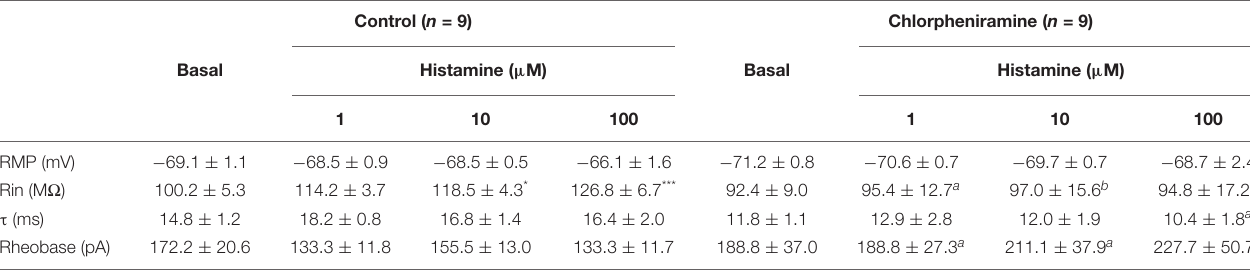
Passive membrane properties were obtained from experiments illustrated in Figure 4 . The membrane time constant ( τ ) was obtained at − 30 pA. Differences within the same group were evaluated with repeated-measures two-way ANOVA and post hoc Dunnett’s multiple comparison test. *P < 0.05, ***P < 0.001 versus basal. Differences between groups were analyzed with Mixed ANOVA of Repeated Measures followed by Sidak’s test. a P < 0.05, b P < 0.01, c P < 0.001 versus control. basal, tiotidine, and tiotidine + HA conditions (12.17 ±